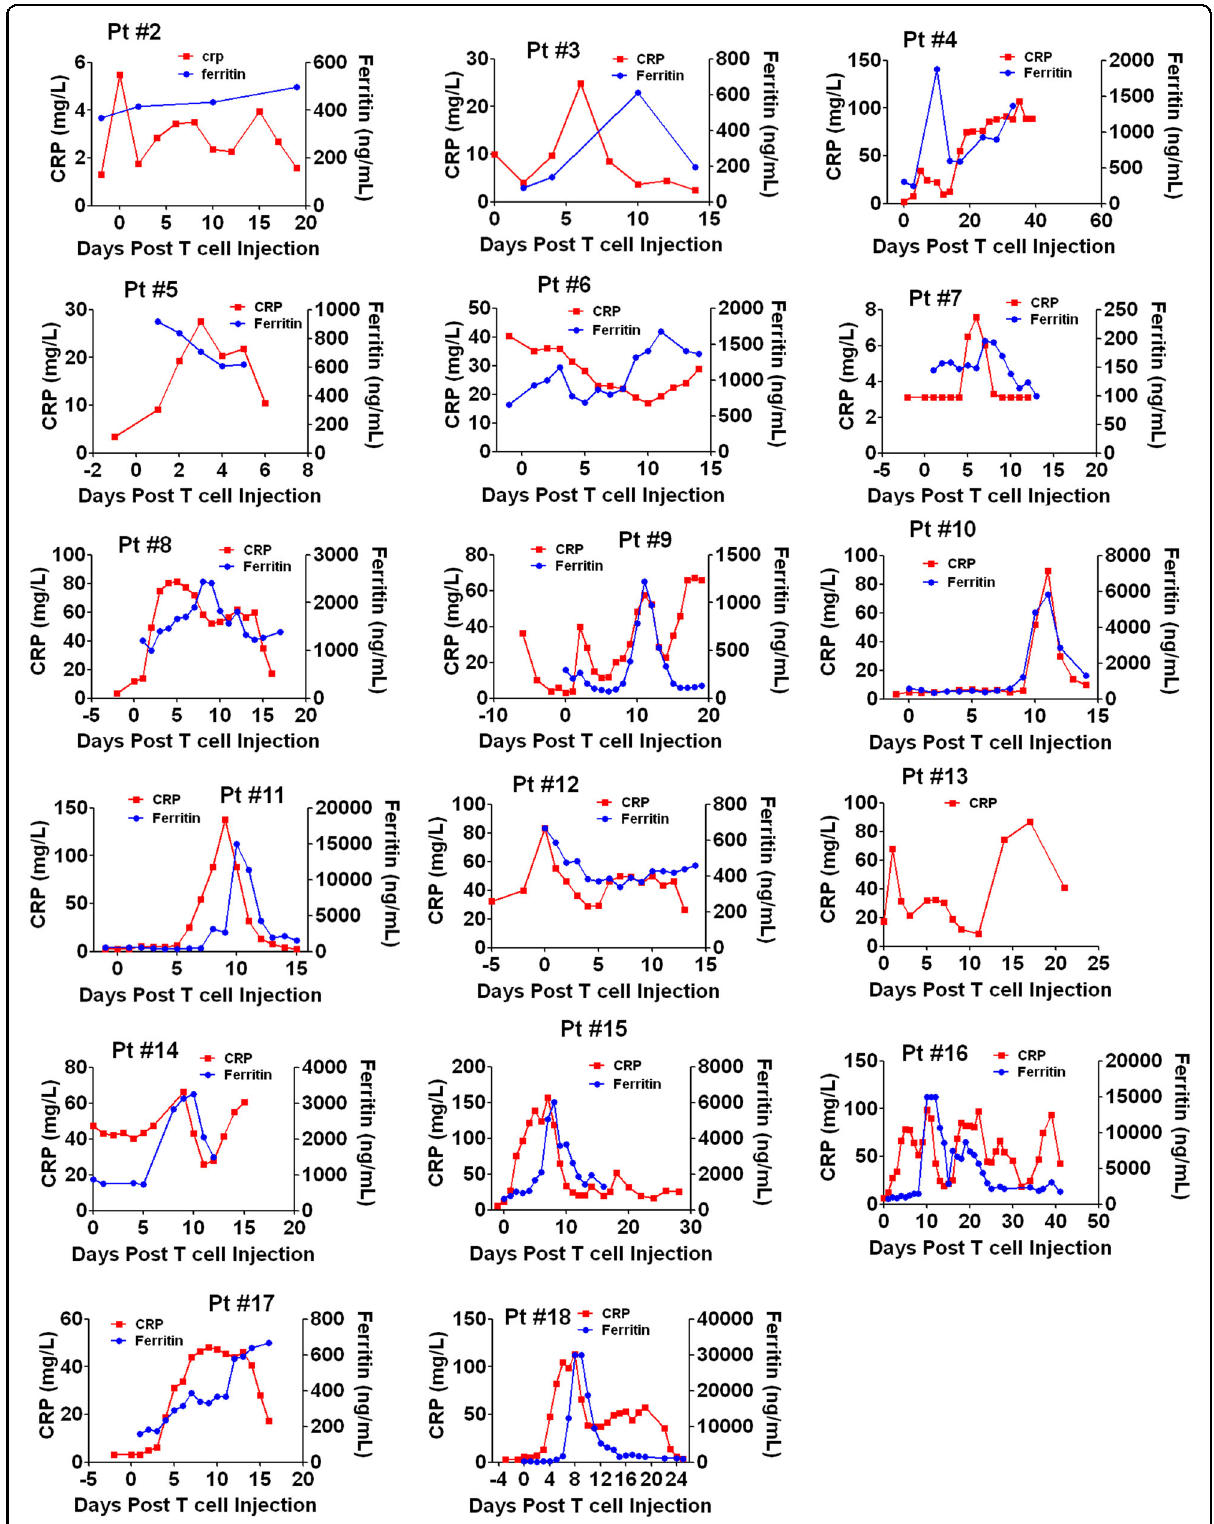
Fig. 4 Changes of CRP and Ferritin in patients treated with CART-aIL6/IL1RA. Patients (as numbered in Table 1) with refractory or relapsed ALL, CLL, Lymphoma, or MM were enrolled and treated with anti-CD19 or anti-BCMA CART secreting anti-IL6 scFv and IL1RA. After CART infusion, patients were monitored for recording CRP and Ferritin levels to assess grading of